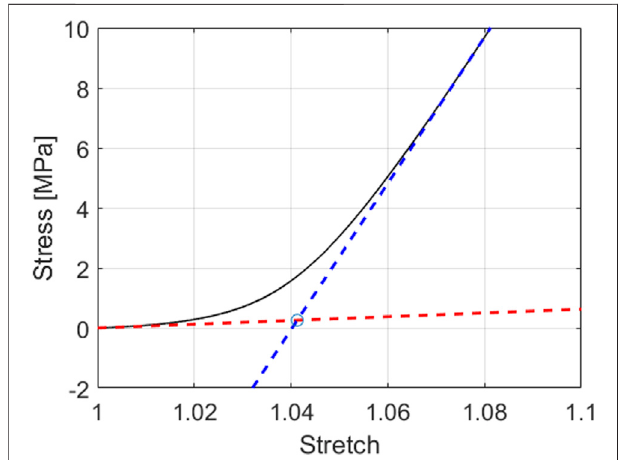
FIGURE 5 | Model-predicted stress-stretch curve for tendinous tissue subjected to uniaxial tensile stress state; for E col (cid:1) 500 MPa, E m (cid:1) E μ (cid:1) 2.5 MPa, θ ini col (cid:1) 27 . 5 ° , f fas col (cid:1) 0 . 6, and f tis fas (cid:1) 0 . 95; with indication of metrics used in sensitivity analysis: initial slope ( see red tangent), fi nal slope ( see blue tangent), tangent intersection point ( see circular mark) - the coordinates of the latter quantify intersection stress and intersection